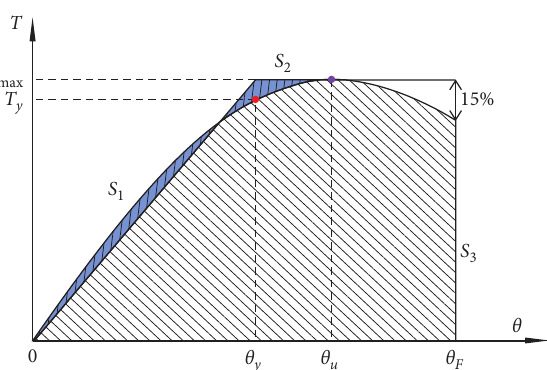
� S 1 2 ) and S 1 , S 2 , S 3 stand for the area of the regions in the torsion-rotation angle